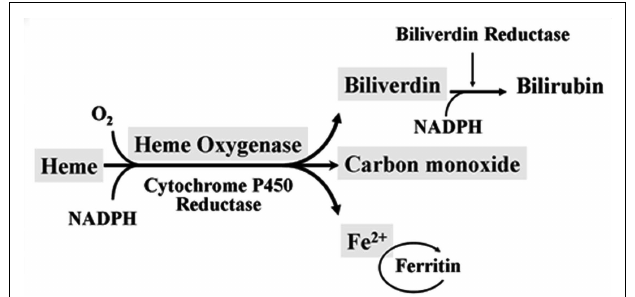
FIGURE 1 | Heme oxygenase enzymatic activity. HO enzymatic leads to the generation of biliverdin, release of carbon monoxide (CO) and Fe 2 + . Biliverdin is transformed into bilirubin by the biliverdin reductase (BVR) enzyme. Fe 2 + can be bound by the iron storage protein ferritin.